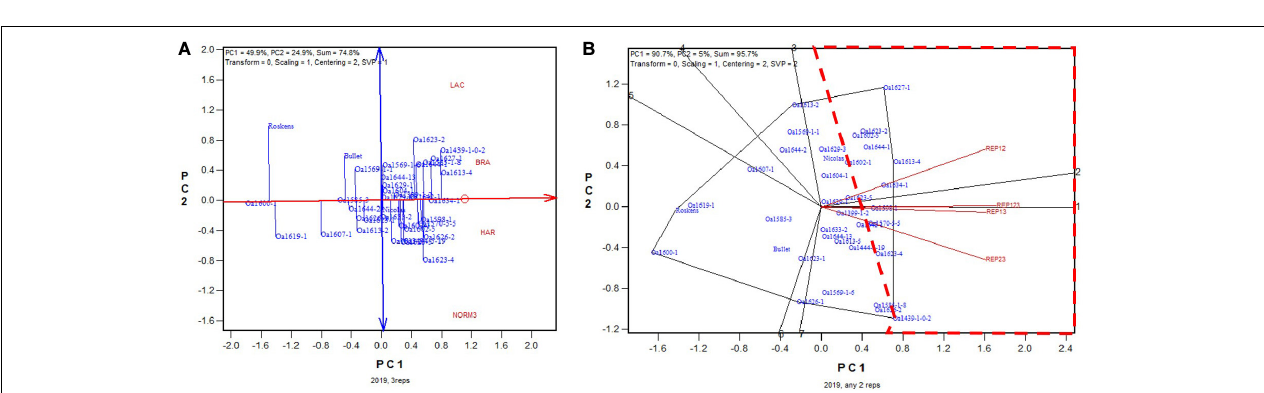
FIGURE 11 | Biplots for the 2018 non-Ontario trials. (A) GGE biplot to show genotype ranking based on data from all three replicates, and (B) summary biplot to show the genotype rankings based on all three replicates and on any two of them. REP123, genotypic ranking based on all three replicates; REP12, genotype ranking based on replicates 1 and 2; REP13, genotype ranking based on replicates 1 and 3.